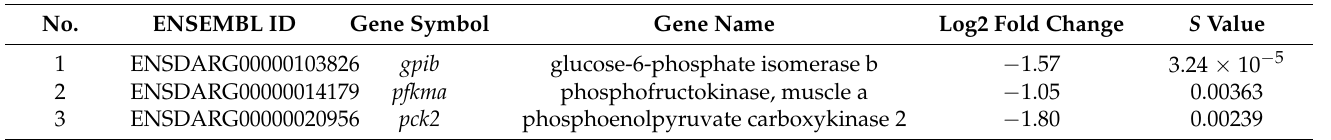
Table 1. Downregulated genes in glycolysis and gluconeogenesis pathways in tlr2 − / − versus tlr2 +/+ zebrafish larvae